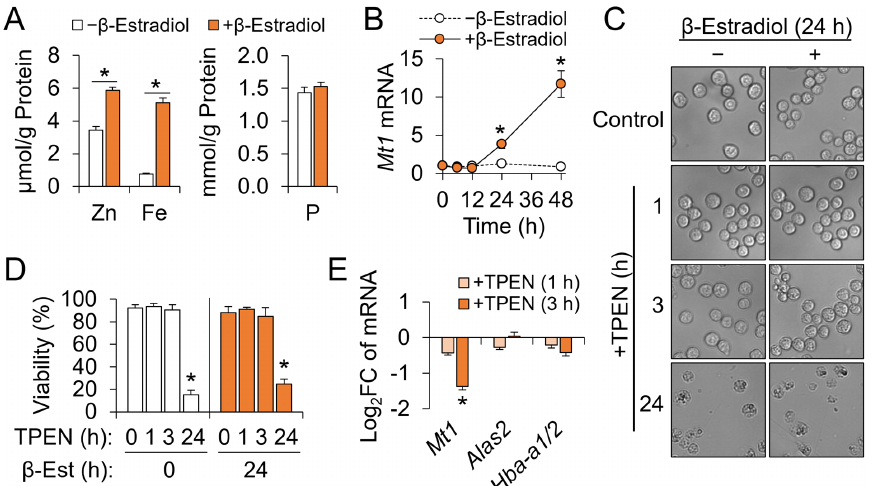
Figure 1. G1E ‐ ER4 erythroid progenitors accumulate zinc during differentiation and require zinc for survival. The differentiation was induced by adding β‐ estradiol ( β‐ Est). ( A ) Accumulations of total cellular zinc and iron in developing G1E ‐ ER4 cells 48 h after terminal erythroid differentiation. Cellular contents were normalized to total protein contents ( n = 4). ( B ) Increased Mt1 transcript abundance by erythroid development, normalized to Tbp ( n = 3). ( C ) Representative cell microscopic images of G1E ‐ ER4 cells treated with or without 10 μ M TPEN. β‐ Est treatments were for 24 h. ( D ) Effects of TPEN on viability of G1E ‐ ER4 cells treated with or without β‐ Est ( n = 4). ( E ) Effects of TPEN on Mt1 , Alas2 , and Hba ‐ a1/2 transcript abundance normalized to Tbp ( n = 3). Data presented as mean ± SD. * p < 0.05. β‐ Est, β‐ estradiol; TPEN, N,N,N ′ ,N ′‐ tetrakis(2 ‐ pyridylmethyl) ‐ ethylenedi ‐ amine.